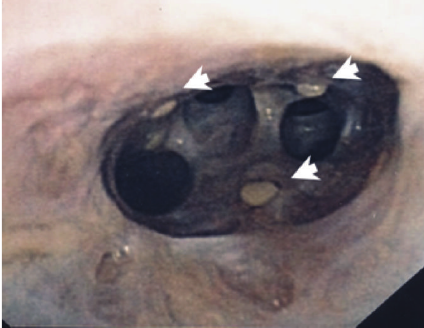
Figure 5: Bronchoscopy images after two weeks of antifungal therapywithdiffuselyabnormalappearingmucosaandtanadherent plaques (arrows).